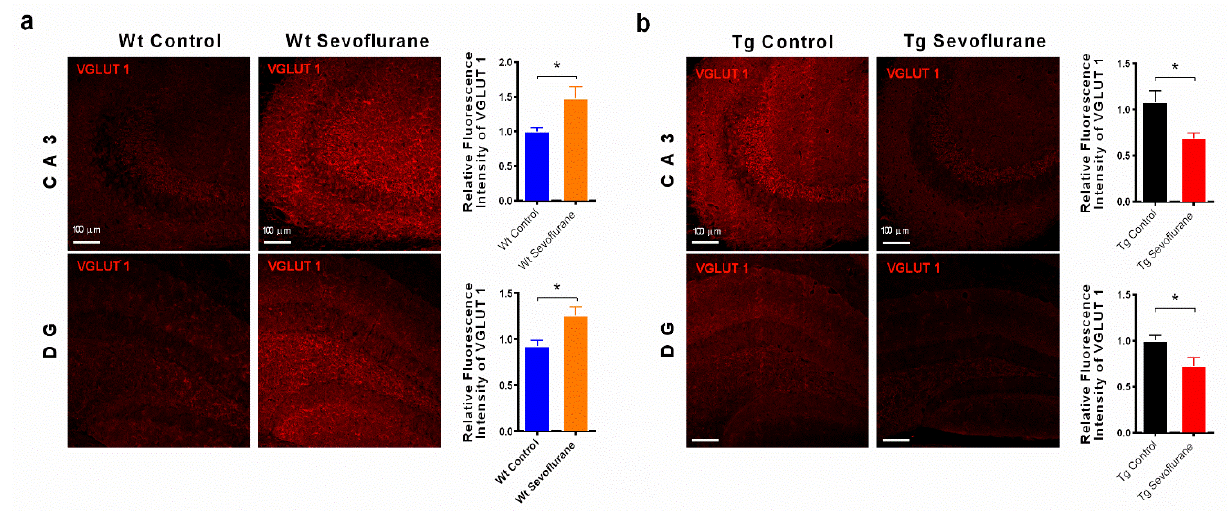
Figure 3. Sevoflurane reduced VGLUT1 expression in 3 × Tg mice VGLUT1 immunofluorescence in the hippocampus of ( a ) wild-type and ( b ) 3 × Tg mice. A significant reduction in VGLUT1 was found in the hippocampus of 3 × Tg mice after sevoflurane exposure, but not in wild-type mice. Bar graphs show the quantification of immunofluorescence intensity in the images. Data correspond to the mean ± SEM ( n = 4). * p < 0.05 in comparison to the control. Values were analyzed using the unpaired t -test.